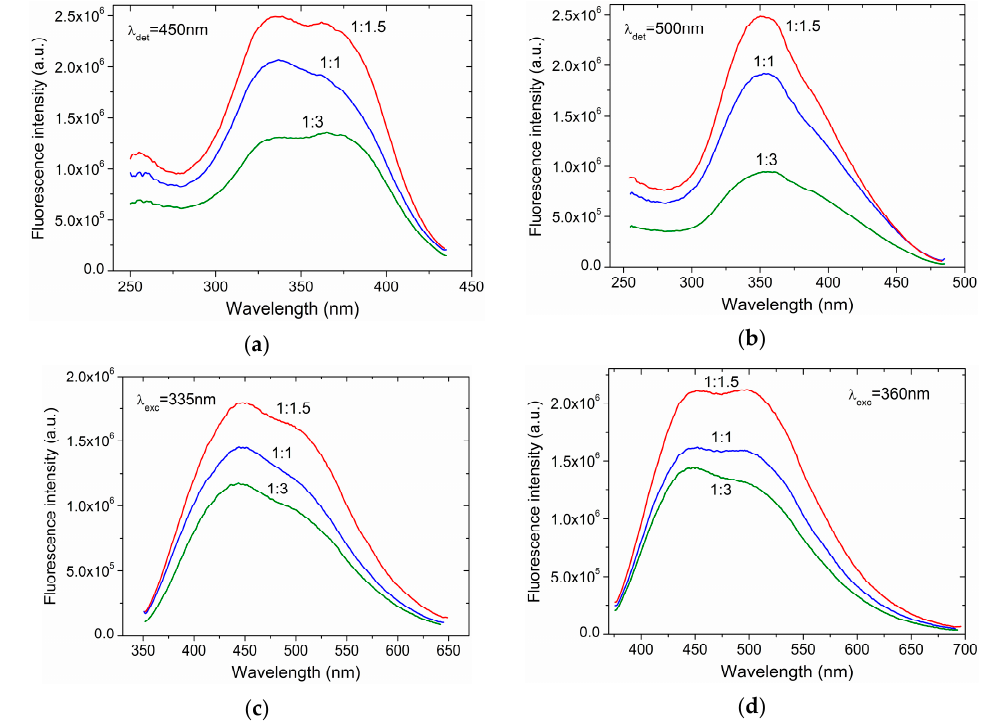
Figure 1. Excitation ( a , b ) and emission ( c , d ) spectra of the composites based on silica and citric acid ureates (1:1, 1:1.5 and 1:3) after thermal treatment at 270 °C. ( λ det —detection wavelength, λ exc —excitation wavelength).